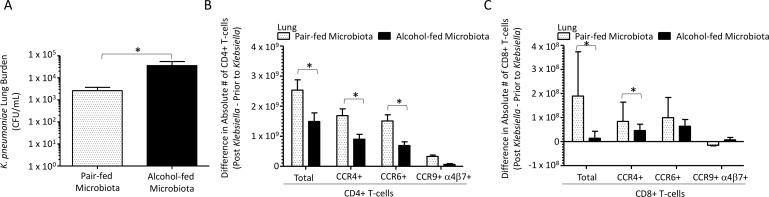
Alcohol-associated dysbiosis increases host susceptibility to Klebsiella pneumoniae in mice.(A) Klebsiella lung burden (CFU/ml) at 48 hrs. post infection in pair-fed recolonized and alcohol-dysbiosis recolonized treated mice. (B) Difference in absolute number of homing receptor positive lung CD4+ T-cells isolated 48 hrs. post-Klebsiella infection from values obtained pre-infection in alcohol-dysbiosis and pair-fed recolonized mice. (C) Difference in absolute number of homing receptor positive lung CD8+ T-cells 48 hrs. post-Klebsiella infection from values obtained pre-infection in alcohol-dysbiosis and pair-fed recolonized mice. Bars represent the mean of the cell counts post infection minus the cell counts prior to infection ± SEM. * indicates P < 0.05, by Mann-Whitney U or by ANOVA with Dunn’s correction. N = 10/group.